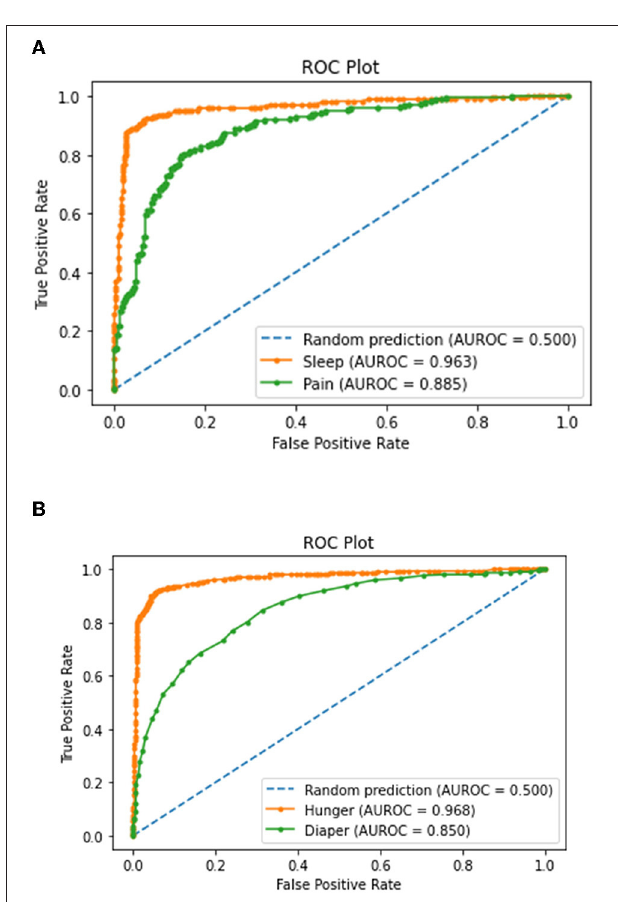
FIGURE 15 | Receiver operator characteristic (ROC) curve for (A) sleep and pain classes and (B) hunger and diaper classes.